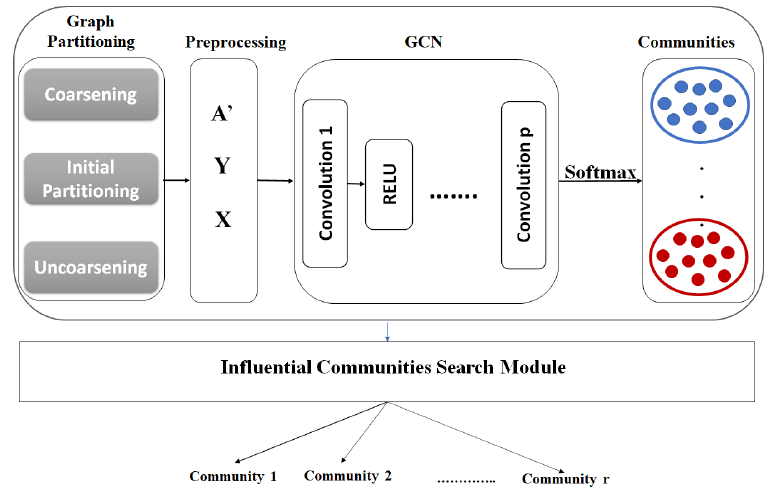
Figure 1. InfACom-GCN